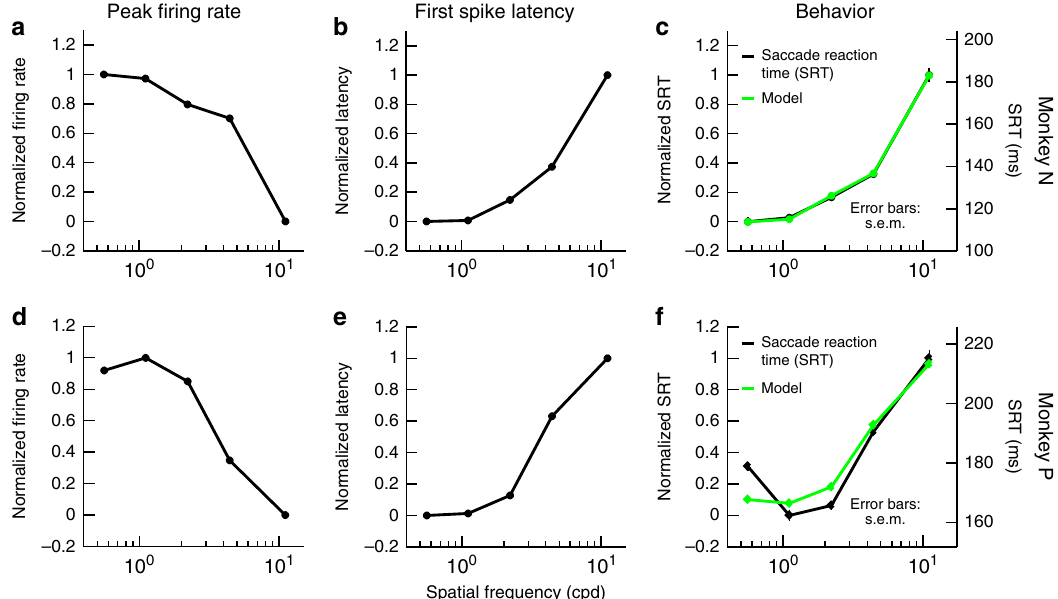
Fig. 8 Strong correlation between SC visual response properties and saccadic reaction time (RT). a For monkey N, we plotted average response strength as a function of spatial frequency for all neurons covering an eccentricity similar to an eccentricity used in separate behavioral sessions requiring a saccade to the gratings (Methods). Firing rates were normalized in the range of 0 – 1 from lowest to highest response. Low spatial frequencies were associated with higher responses, as shown in Fig. 6. b We performed a similar analysis for neural response latency from the same neurons; this time, low spatial frequencies were associated with more rapid neural responses, as shown in Fig. 4. c The black curve shows the monkey ’ s saccadic RT as a function of spatial frequency from completely different behavioral sessions, in which an orienting saccade towards the grating was required as quickly as possible after the grating ’ s onset (Methods). The green curve shows a linear combination of the neural curves in a , b (Methods). There was a high correlation between SC visual response properties and saccadic RT, even though the monkey never made target-directed saccades to the gratings during the recordings of our neural data. d – f Similar analyses for monkey P. Error bars are de fi ned in the fi gure where appropriate (note that the error bars for saccadic RT are sometimes too small to see; error bars for neural parameters were shown in earlier fi gures). For monkey N, model parameters a , b , and c from Eq. (2) in Methods were − 0.458, 0.537, and 0.465, respectively, and the percentage explained variance of the data by the model was 99.9%. For monkey P, the parameter values were − 0.427, 0.463, and 0.5, respectively, and the percentage explained variance of the data by the model was 89.7%. In both animals, there was a roughly equal correlation between either response strength or fi rst-spike latency and saccadic RT, because the fi rst two parameters in Eq. (2) had roughly equal absolute